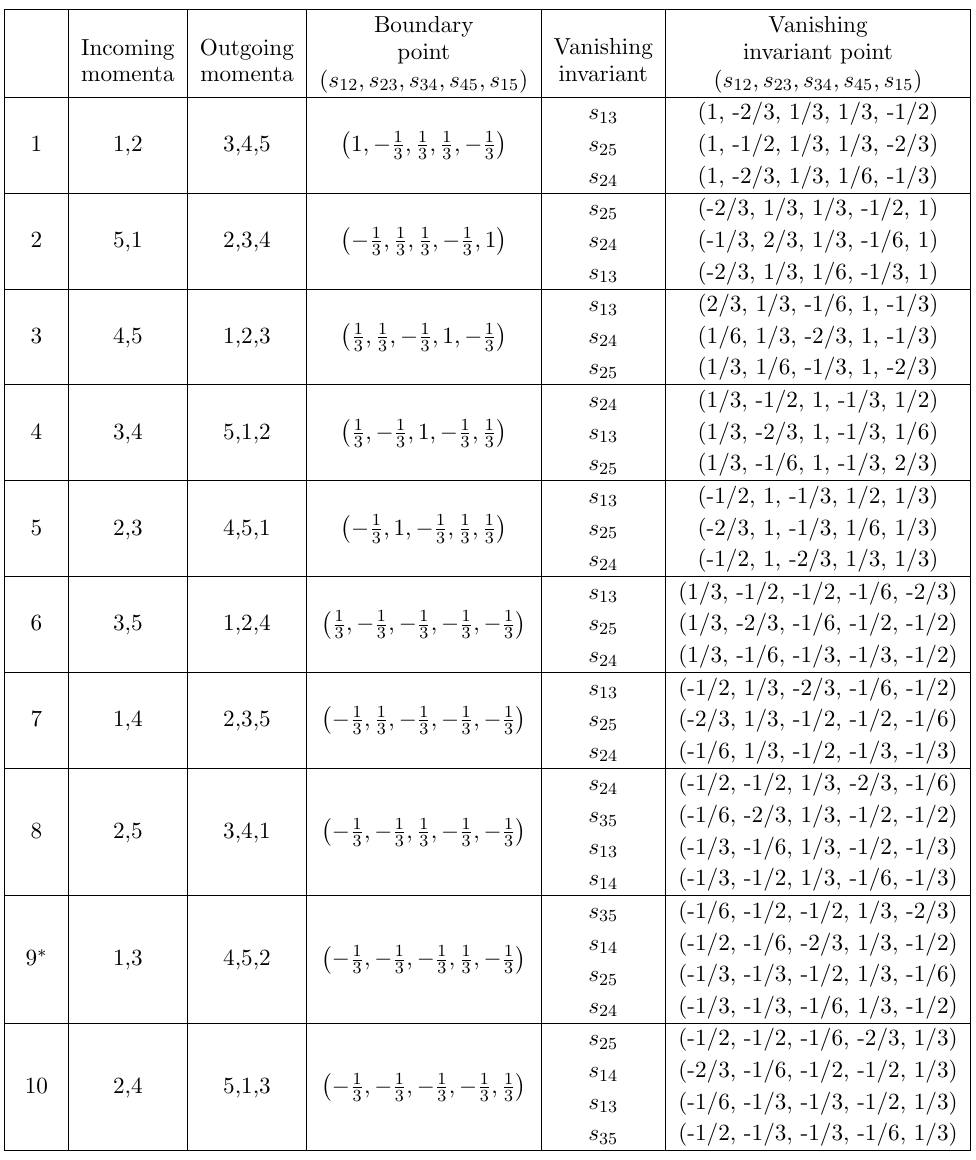
Table 5 . List of boundary points for each of the ten physical regions, together with the s i;i +2 = (cid:1) = 0 points used to obtain contraints from spurious-singularity cancellations. The ( (cid:3) ) indicates the physical region where spurious-singularity cancellations in the four points reported leave the boundary condition on integral I 38 unconstrained. The value of the integral in this region can be found by analytically continuation from the Euclidean as described above eq.